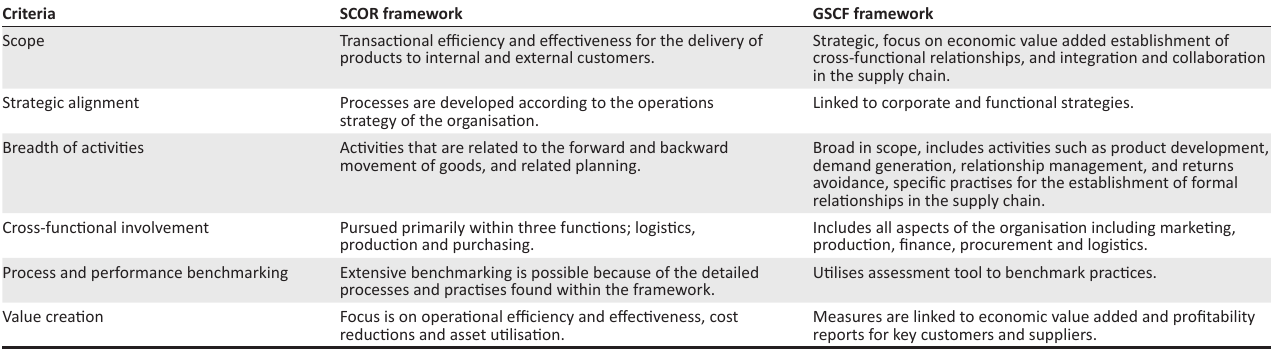
TABLE 1: Comparison between Supply Chain Operations Reference and Global Supply Chain Forum frameworks.